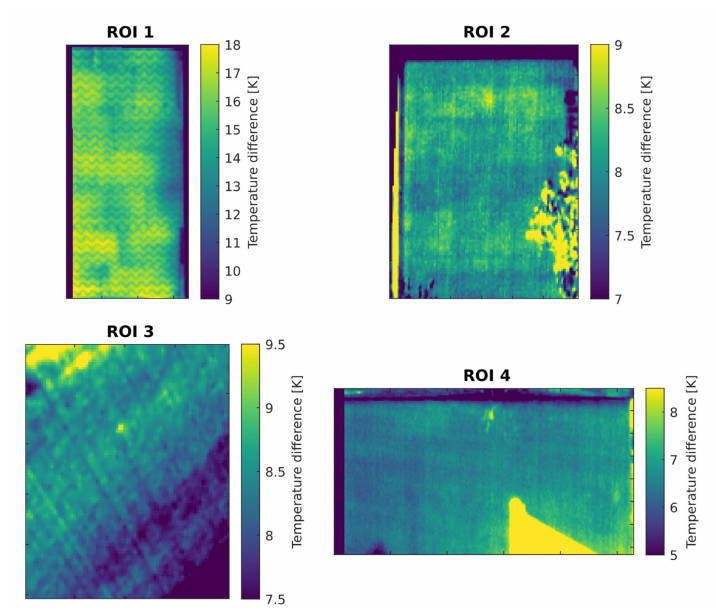
Figure 9. Perspective-corrected difference